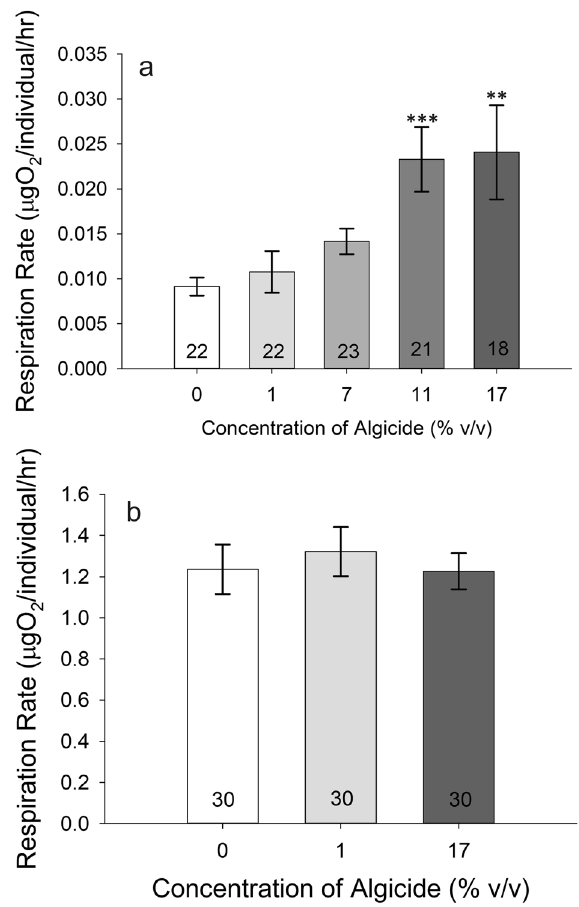
Figure 5. Respiration rates of Callinectes sapidus ; numbers on the bars represent sample size. ( a ) Respiration rate of C. sapidus zoeae as a function of algicide concentration. Asterisks mark rates for algicide concentrations that are significantly different from the 0% control animals. ( b ) Respiration rate of C. sapidus megalopae as a function of algicide concentration. (** p < 0.01; *** = p <